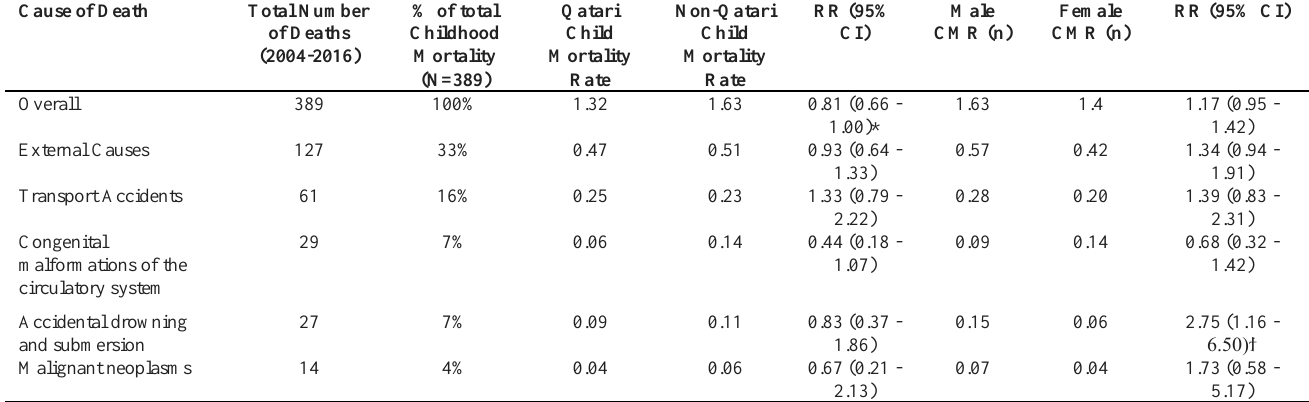
Table 3. Prominent causes of childhood mortality and relative risks by sex and nationality for 2004-2016 Despite a significant decrease in the mortality trend for females (Kendall tau=-0.45, p=0.038) was observed, the sex ratio was found to be less than 1 (0.68)